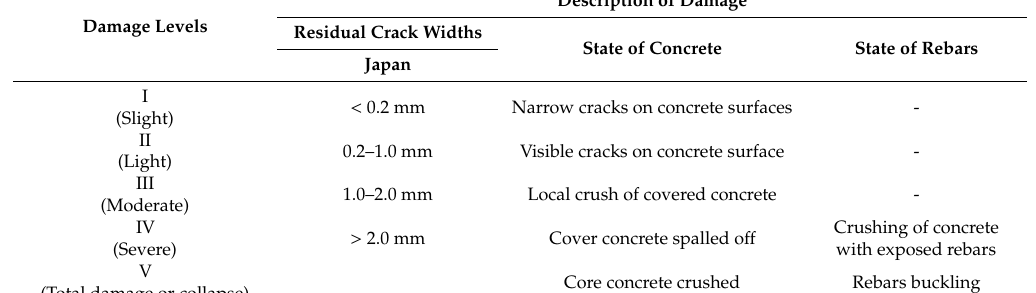
( h ) Figure 9. Damage pattern of each specimen after dynamic testing. ( a ) FF-15S-II; ( b ) FF-15S-III; ( c ) FF- 15S-IV; ( d ) FSF-15S-II; ( e ) FSF-15S-III; ( f ) FSF-15S-IV; ( g ) SF-30S-II; ( h ) SF-30S-III . In the JBDPA (Japan Building Disaster Prevention Association) guidelines [25,26], the damage